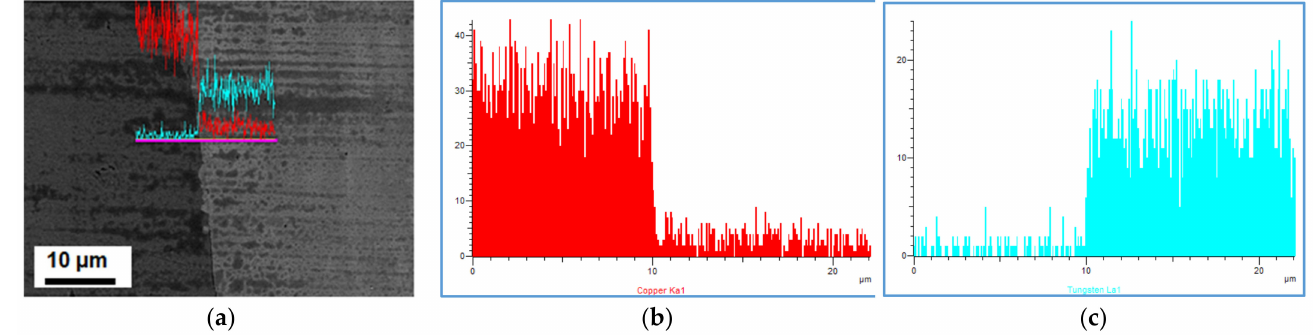
Figure 5. The SEM micrographs ( a ) and EDS profiles ( b , c ) of the Cu-W interface in the Cu-W composite with a rhombic dodecahedron W-skeleton.